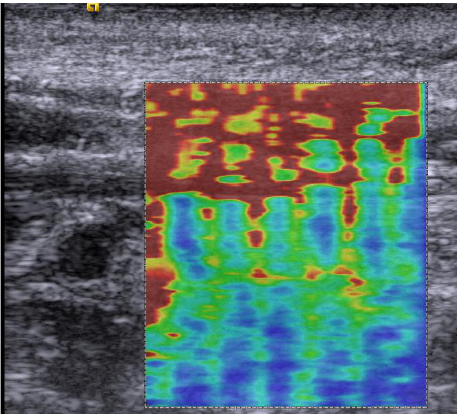
Figure 2. Elastogram of a maximal voluntary isometric contraction with a discontinuous, artifactual appearance and saturated measurements (dark red color). appearance and saturated measurements (dark red